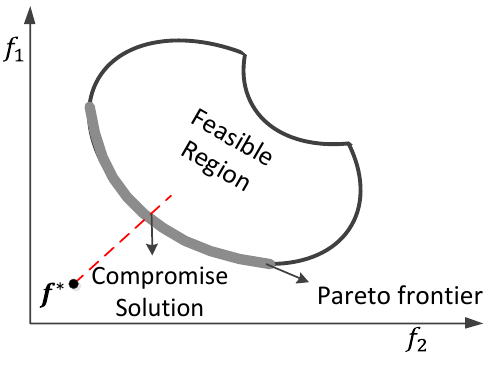
Figure 1. Compromise optimization in Pareto frontier for the objective functions f 1 and f 2 . f ∗ is a utopia